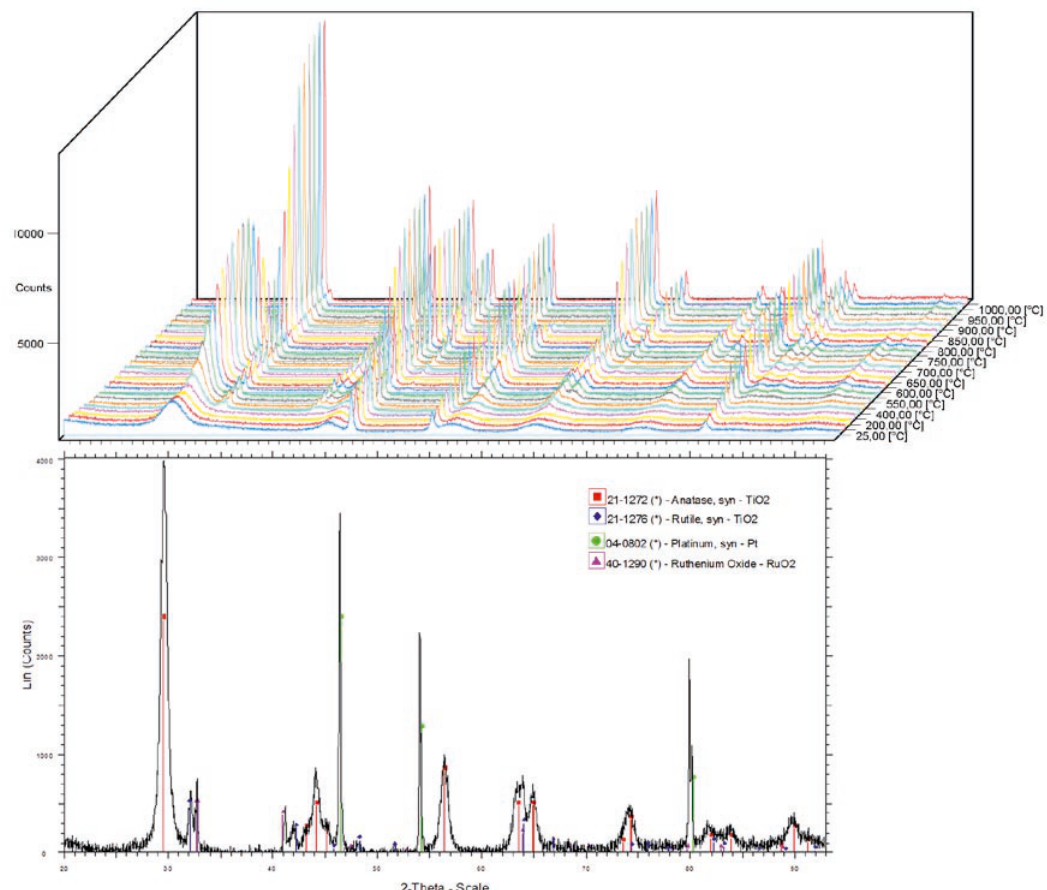
Figure 1. XRD pattern of a sample of TiRu1 as a function of temperature (25 -